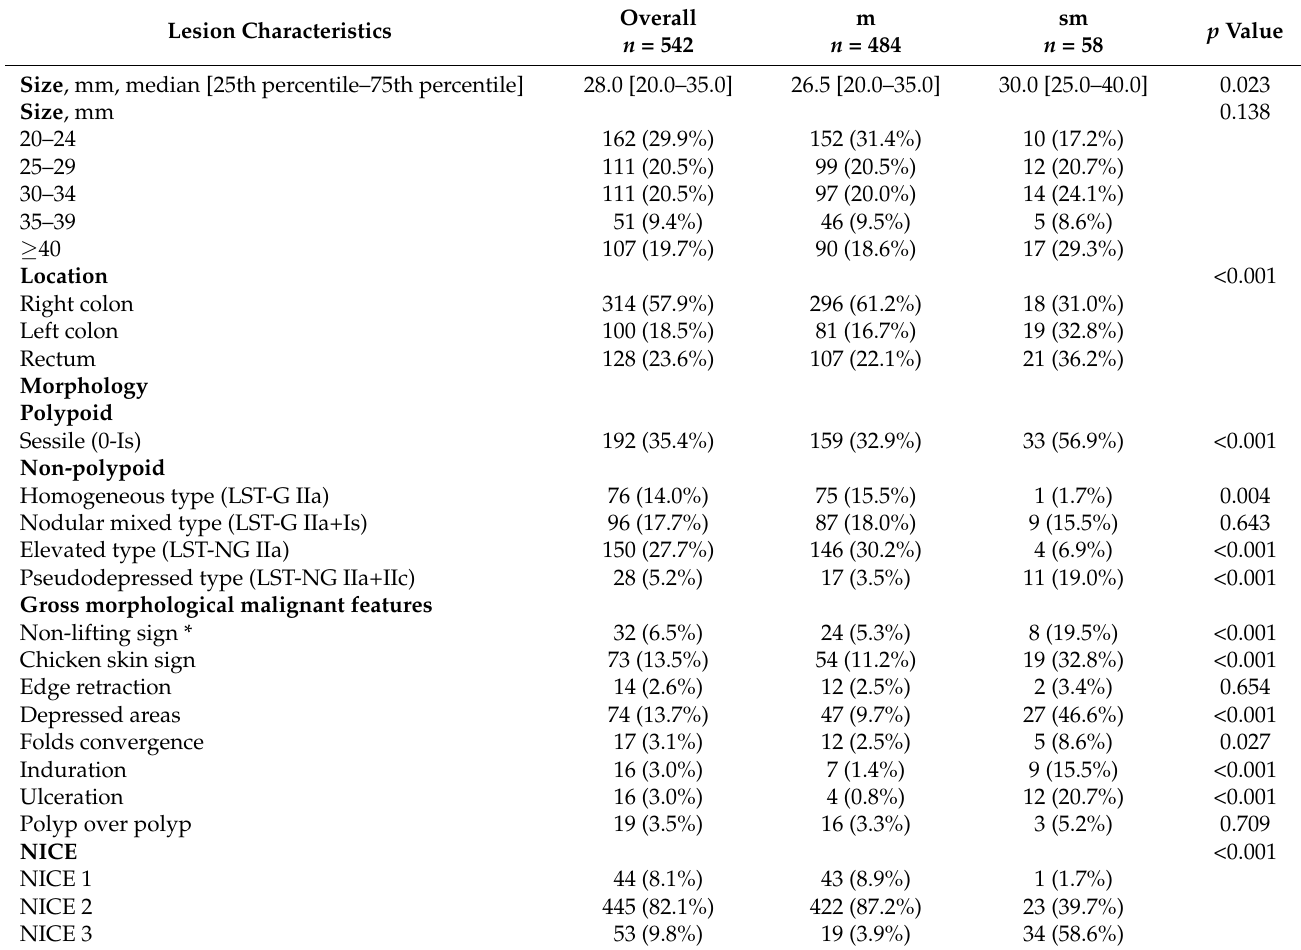
Table 1. Lesion characteristics according to the presence of intramucosal neoplasia (m) or submucosal invasion